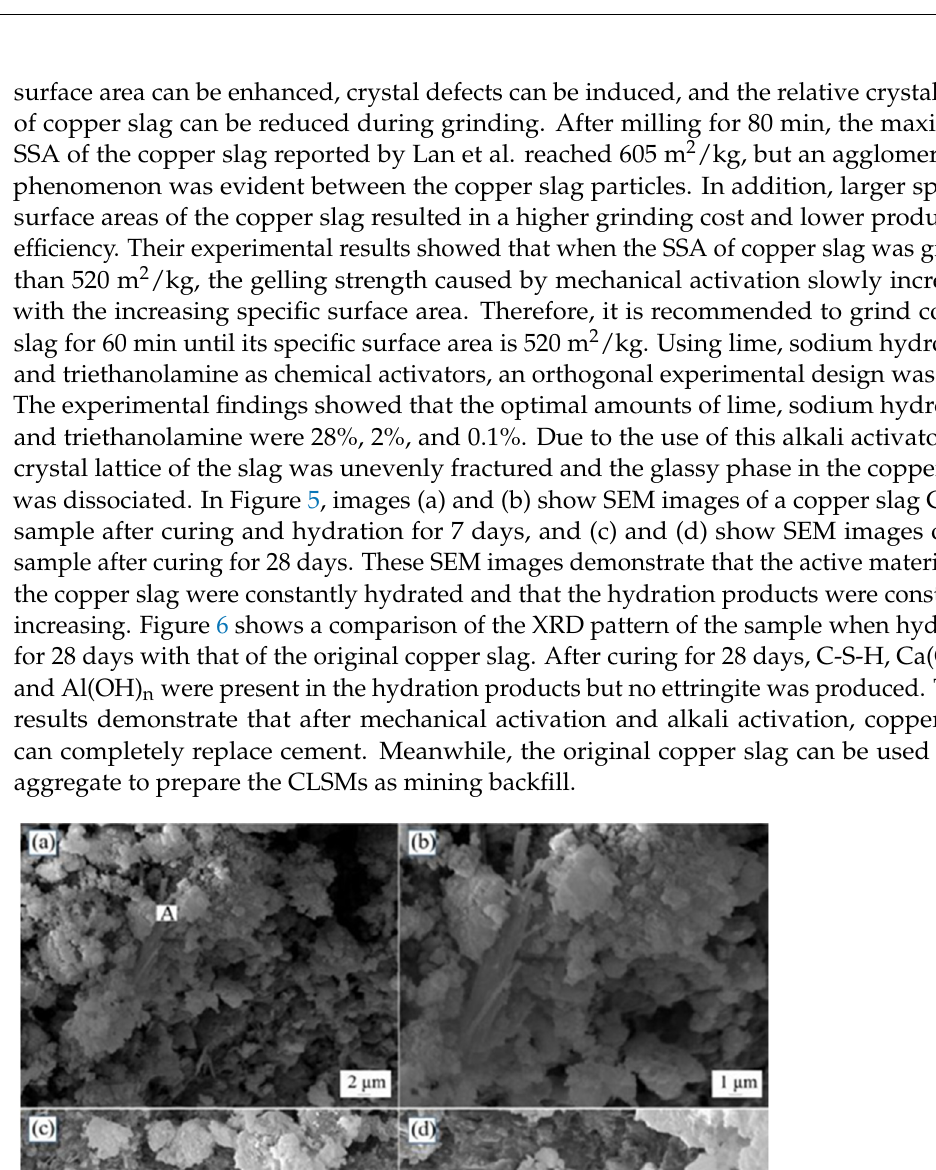
Figure 6. XRD patterns of original copper slag and hydrated sample products after 28 days [30]. 2.5. Other Smelting Waste 2.5.1. Air-Cooled Blast-Furnace Slag Air-cooled blast-furnace slag (ACBFS) is usually used as an aggregate in concrete because it has little or no binding ability due to its slow cooling process. ACBFS is also used as an aggregate to replace natural sand in the production of CLSMs. W.T. Lin et al. [32] reported a combination of water-quenched blast-furnace slag, cement, and circulating fluidized bed ash as cementing materials. Due to its high activity, the water-quenched blast-furnace slag was used as the main binder, with a dosage of 210 kg/m 3 . The dosage of cement was 60 kg/m 3 and the dosage of the circulating fluidized bed ash was 30 kg/m 3 . A CLSM was produced by using circulating fluidized earth ash and ACBFS as aggregates. The results of a fluidity test, 24-hour drop-ball test, and compressive strength test were in accordance with the CLSM requirements for road